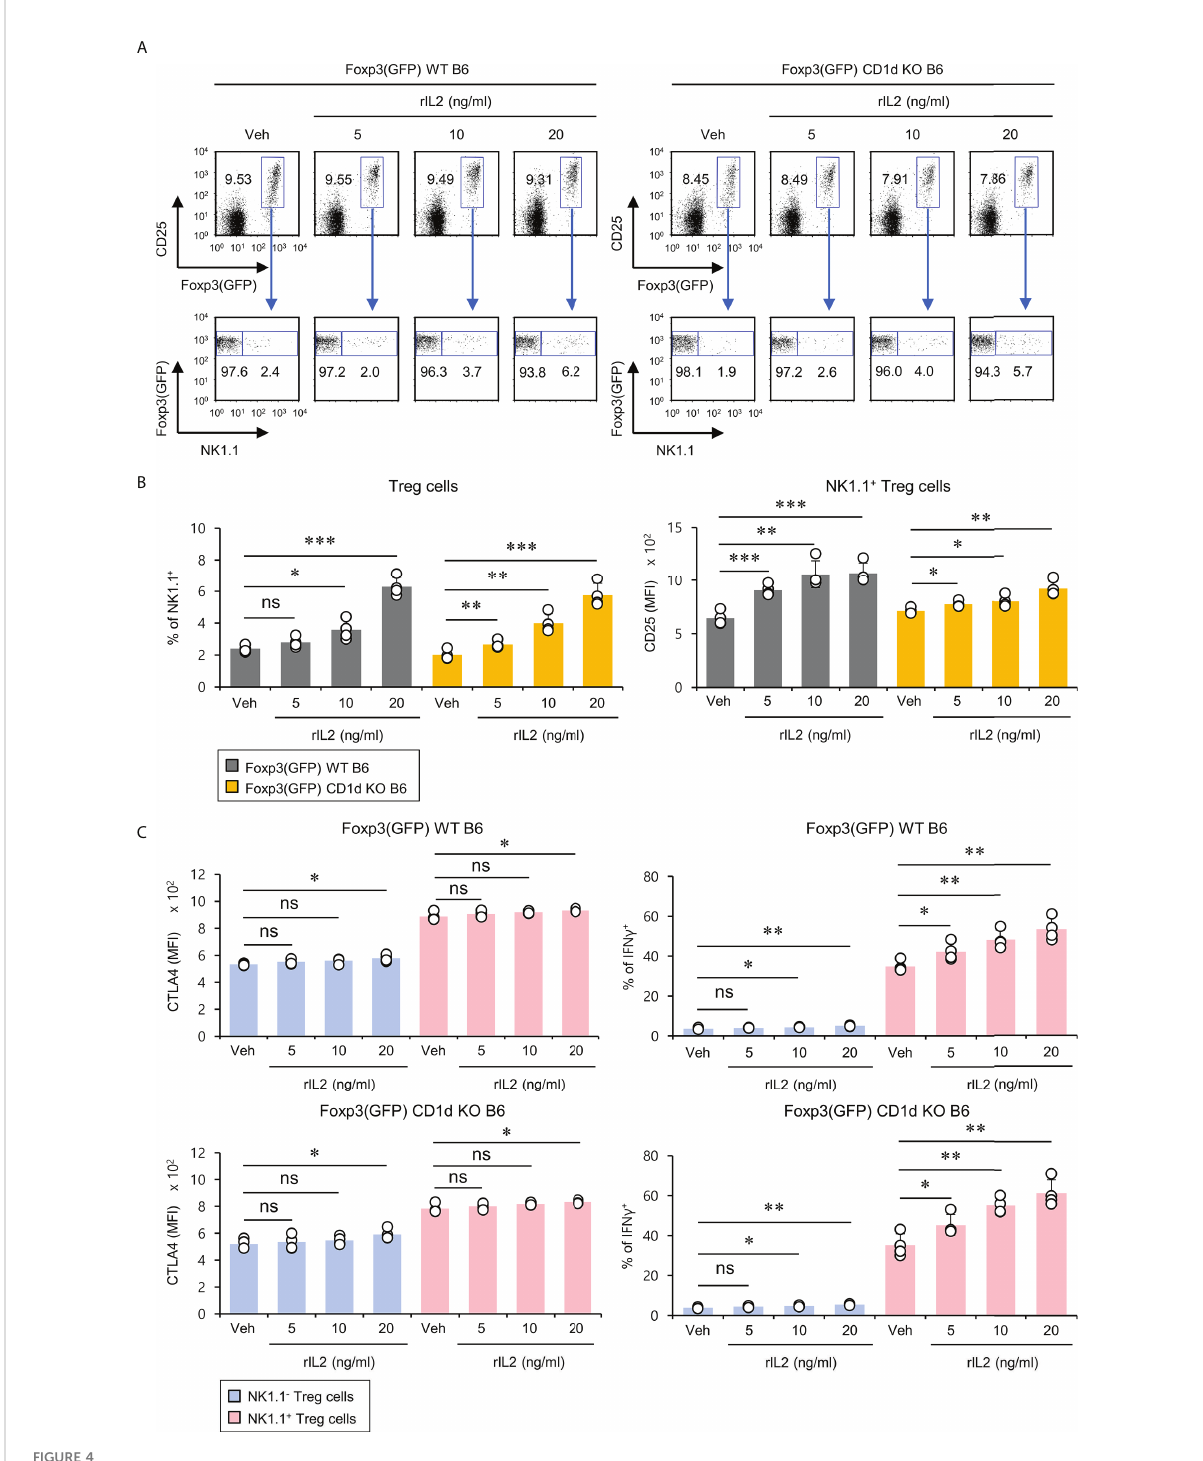
FIGURE 4 IL2 induces the expansion of NK1.1 + Treg cells. Splenocytes were prepared from 8-week-old Foxp3(GFP) WT and Foxp3(GFP) CD1d KO B6 mice. Subsequently, these cells were cultured with rIL2 (5, 10, or 20 ng/ml) for 5 days in vitro . (A, B) The frequency of NK1.1 and CD25 expression on NK1.1 - Treg (NK1.1 - CD4 + Foxp3(GFP) + ) and NK1.1 + Treg (NK1.1 + CD4 + Foxp3(GFP) + ) cells were determined by fl ow cytometry. (C) CTLA4 expression and IFN g production by NK1.1 - Treg (NK1.1 - CD4 + Foxp3 + ) and NK1.1 + Treg (NK1.1 + CD4 + Foxp3 + ) cells were determined by fl ow cytometry. The mean values ± SD ( n = 4 per group in the experiment; Student ’ s t-test; * p < 0.05, ** p < 0.01, *** p < 0.001). One representative experiment of two experiments is shown. ns, not signi fi